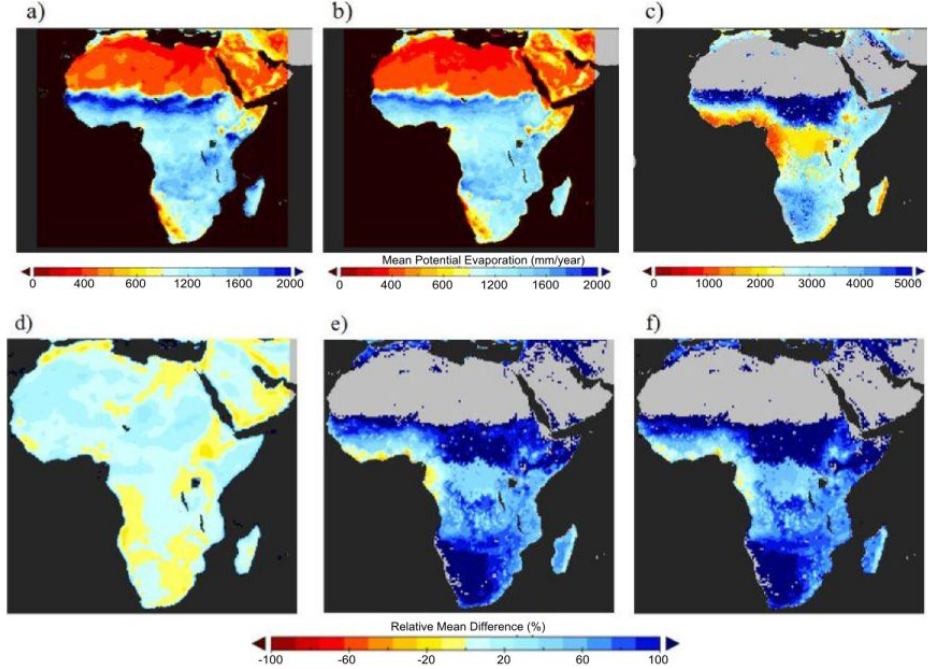
Fig. 4. On top: comparison of mean annual crop-specific potential evaporation computations for Africa with different methods: (a) Penman– Monteith, (b) Hargreaves and (c) MOD16 product (note that the grey area corresponds to missing data and that values are presented at another scale to improve visualization). On the bottom: relative mean difference (RMD) between (d) Penman–Monteith potential evaporation (PE) and Hargreaves PE, (e) MOD16 PE and Penman–Monteith PE, and (f) MOD16 PE and Hargreaves PE.